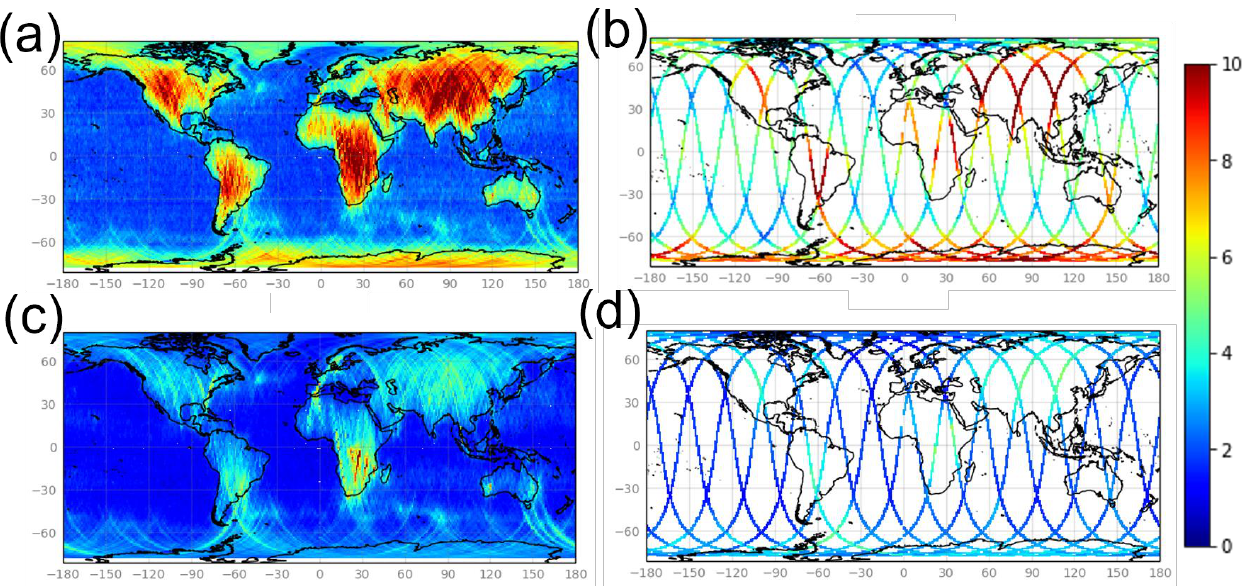
Figure 15. Residual systematic errors after the Level-2 data-driven calibration is applied over a one-year simulation (unit: cm RMS). The left panels are for SWOT’s 21 -day orbit. The right panels are for the one- day orbit. The upper panels are for the “Spectral Allocation” uncalibrated scenario and the lower panels are for the “Current Best Estimate 2021” scenario.